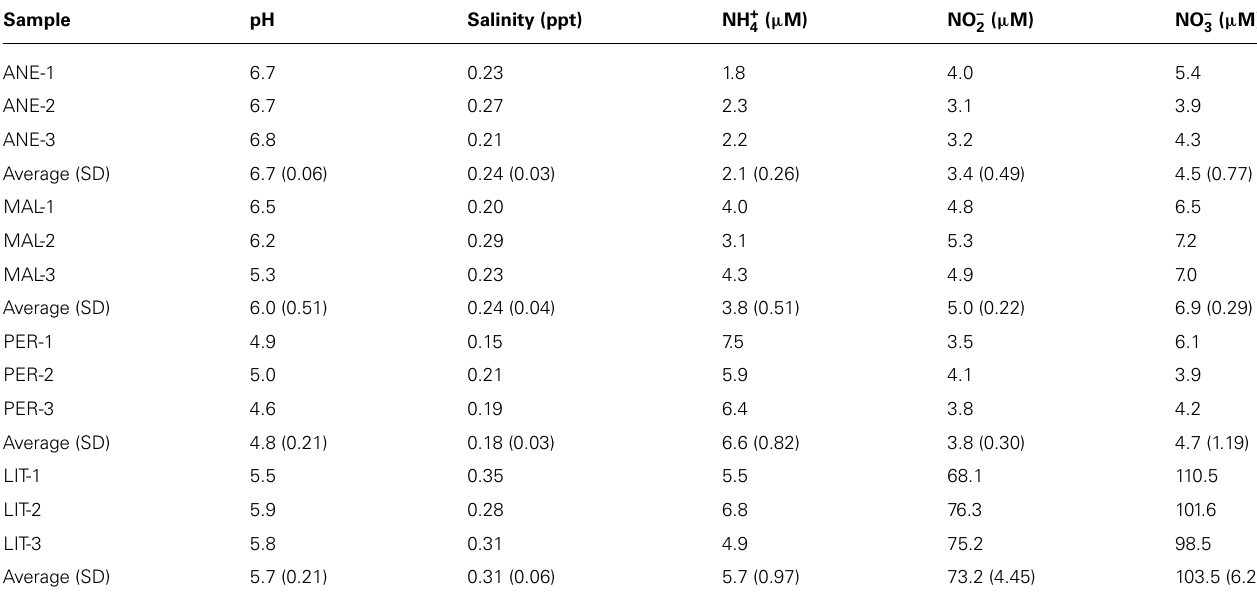
Table 1 | Chemical analysis of ice meltwater fromANE, MAL, PER, and LIT.